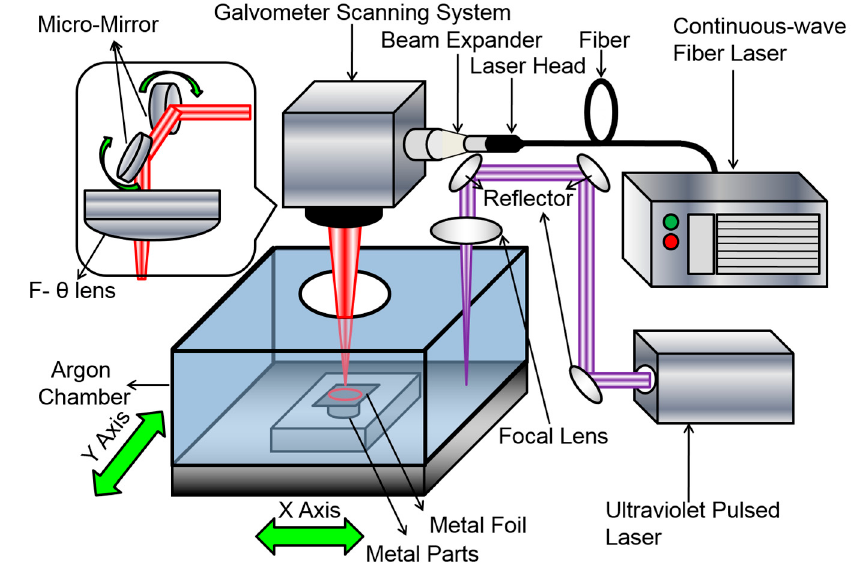
Figure 1. Schematic illustration of the LFP system.